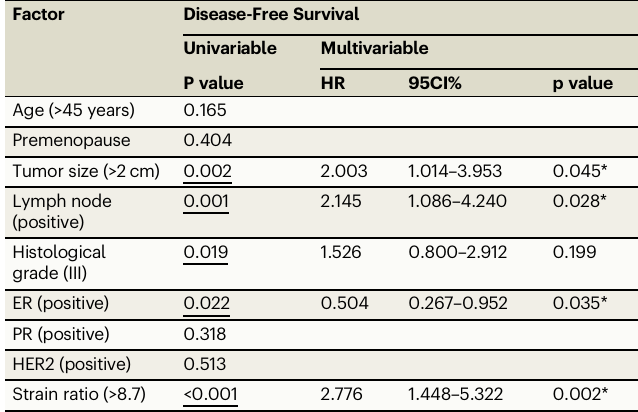
Fig.1 |Matrixstiffnessiscorrelatedwithchemoresistanceandpoorsurvivalin patients with breast cancer. a The lesions of patients with breast cancer in the NAC cohort were evaluated by UE before and after neoadjuvant chemotherapy. Additionally, the pre-treatment biopsies and paired post-treatment resected sam- ples were assessed by HE staining, picrosirius red staining, AFM, and immuno- fl uorescence analysis. Representative images of ultrasound B-mode, UE, HE, picrosiriusredstaining,AFMmap(insertedinpicrosiriusredpictures),andTUNEL/ CK staining are shown ( n =124 patients). White dashed lines represent tumor out- lines. Green and yellow squares in the HE pictures indicate the area shown in the picrosirius red and immuno fl uorescence pictures, respectively. Asterisks (*) indi- cate location of higher magni fi cation views in TUNEL/CK staining images. Picro- sirius red staining viewed under polarized light taken from breast cancer tissues revealthe fi brillarcollagenintheECM;AFMindentationsarerepresentedasaforce heat map. b Quanti fi cation of tumor elastic scores in patients as ( a ) in the NAC cohort. Patients with CR or PR were classi fi ed as chemosensitive patients ( n =83